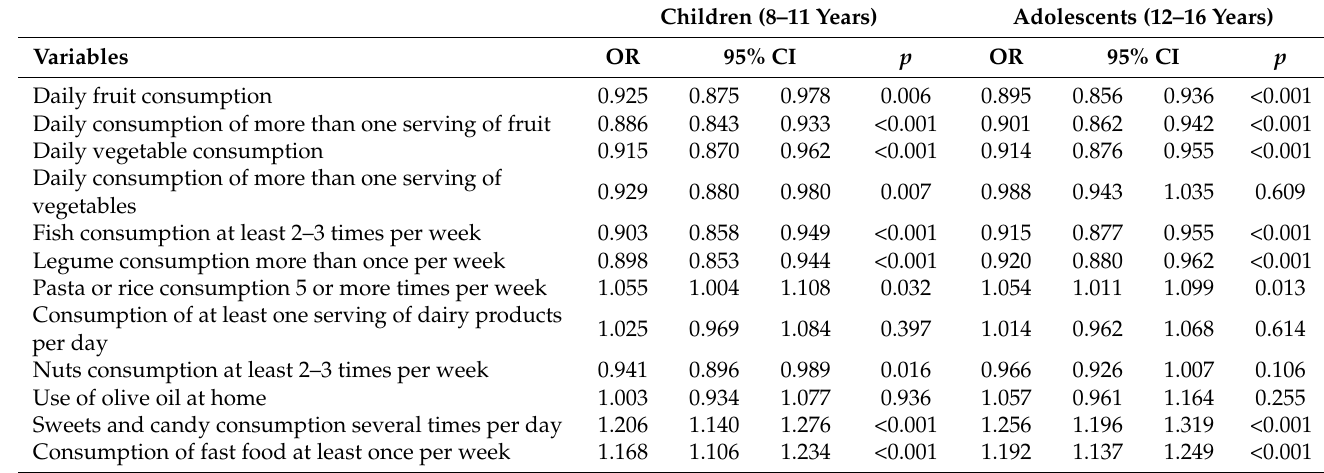
Table 5. Adjusted OR and 95% CI for the effects of screen time on dietary habits selected from the KIDMED